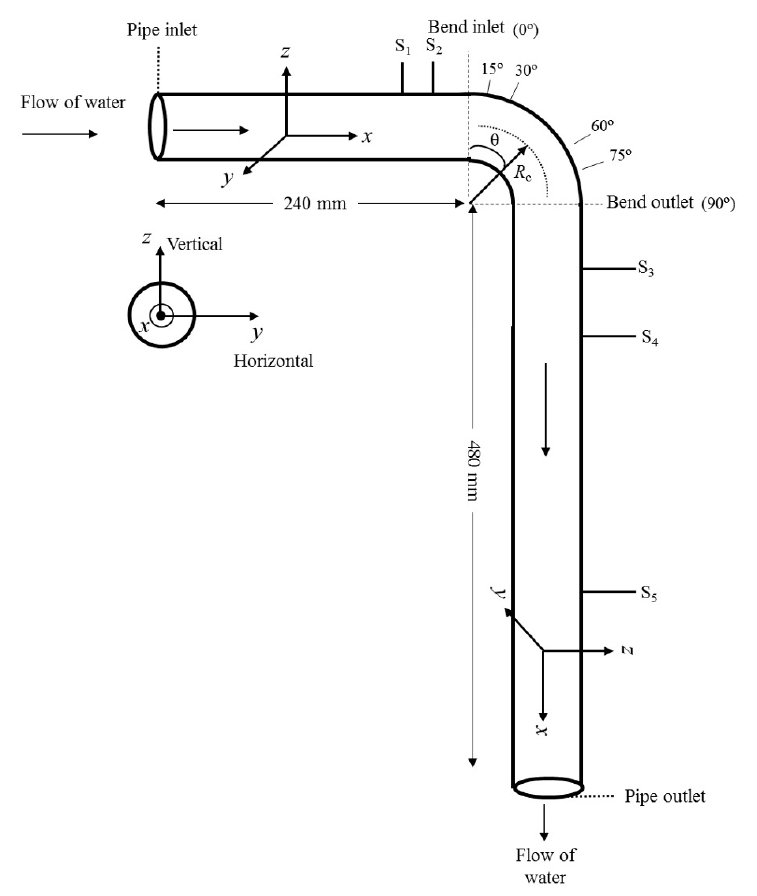
Figure 2. Schematic diagram of the bend geometry and dimensions. The vertical lines on the outer arc of the pipe mark the stations where the numerical results are compared with the experimental